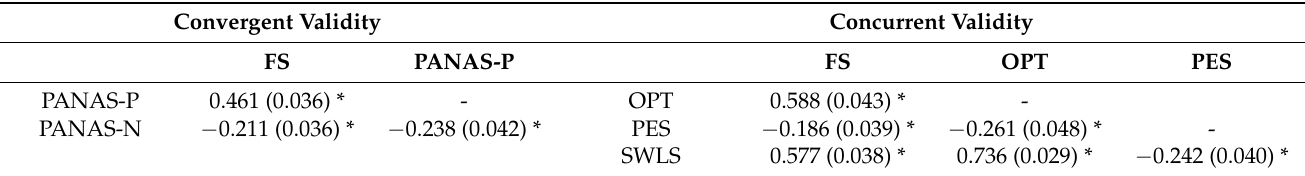
Table 4. Correlation coefficients (standard errors) between the latent variables of the Flourishing Scale and wellbeing measures.